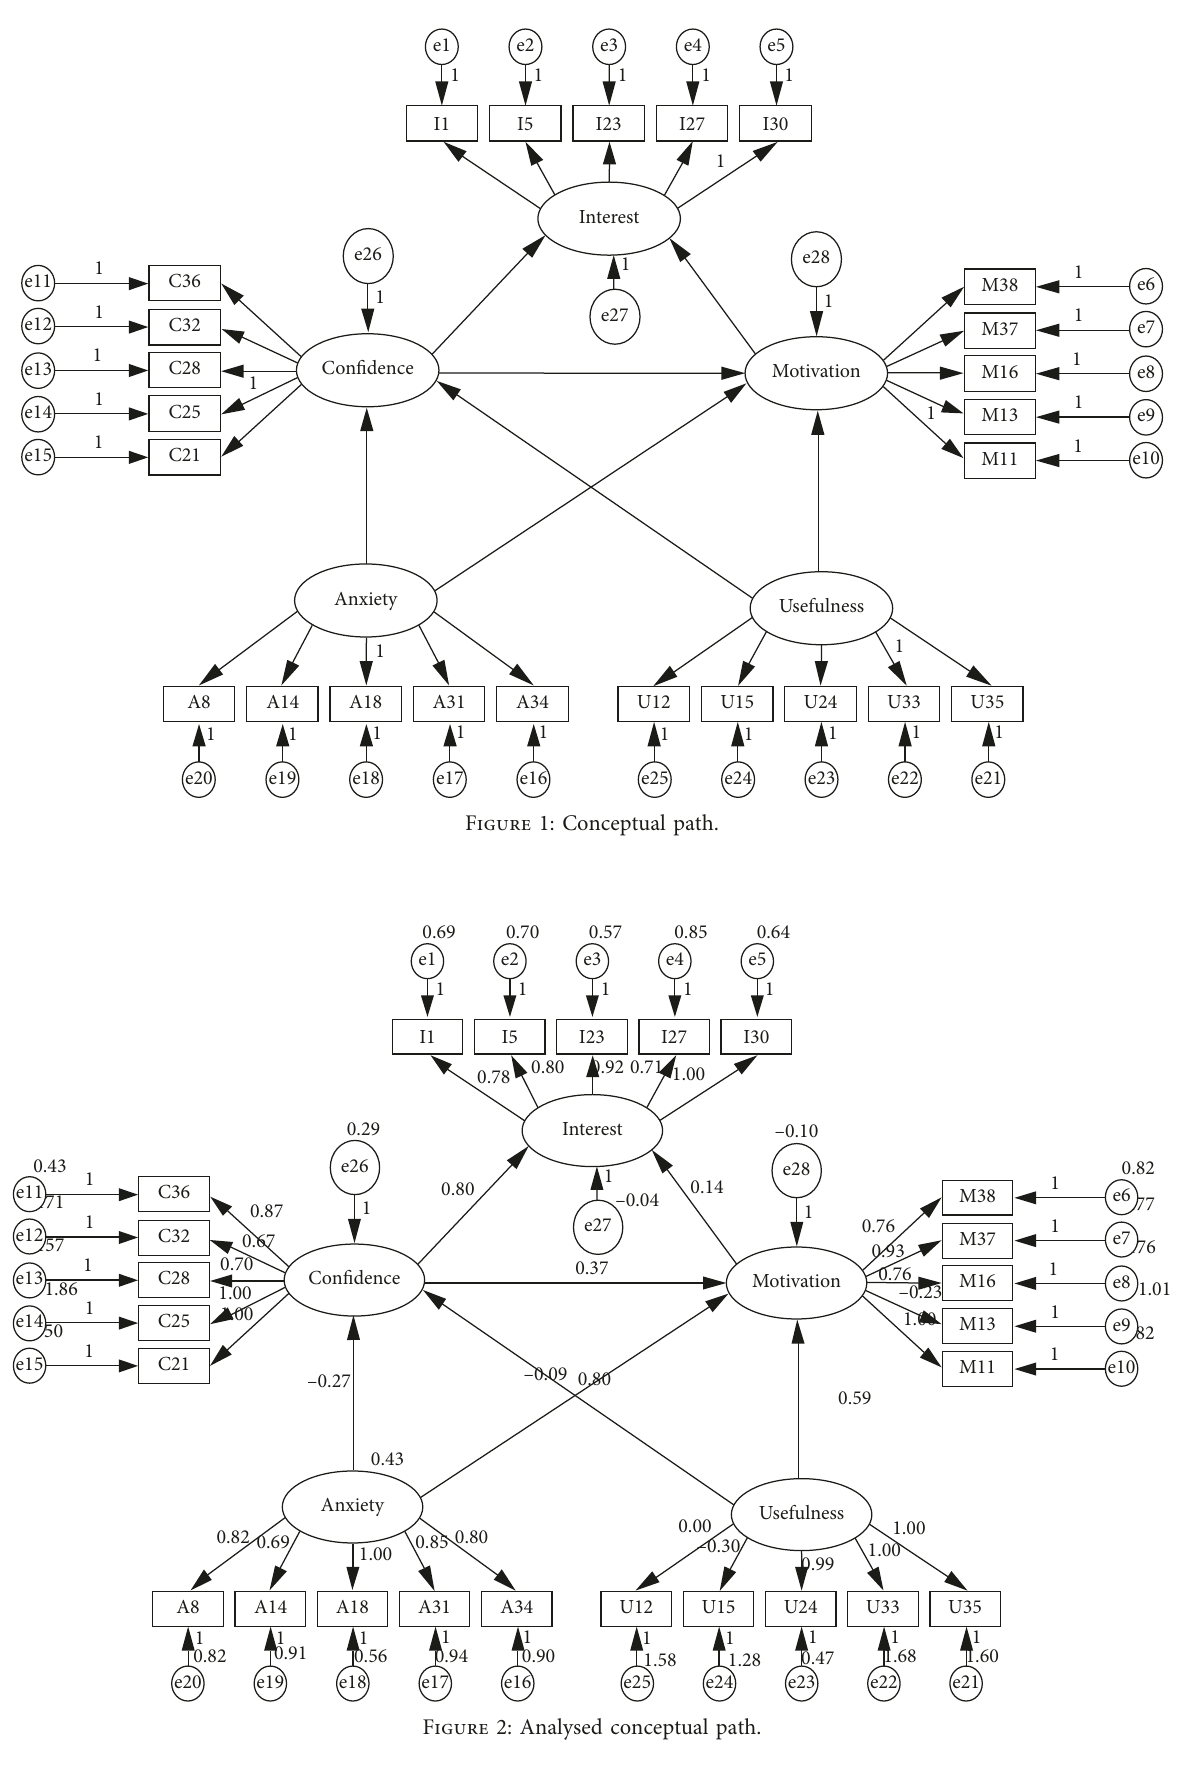
Figure 2: Analysed conceptual